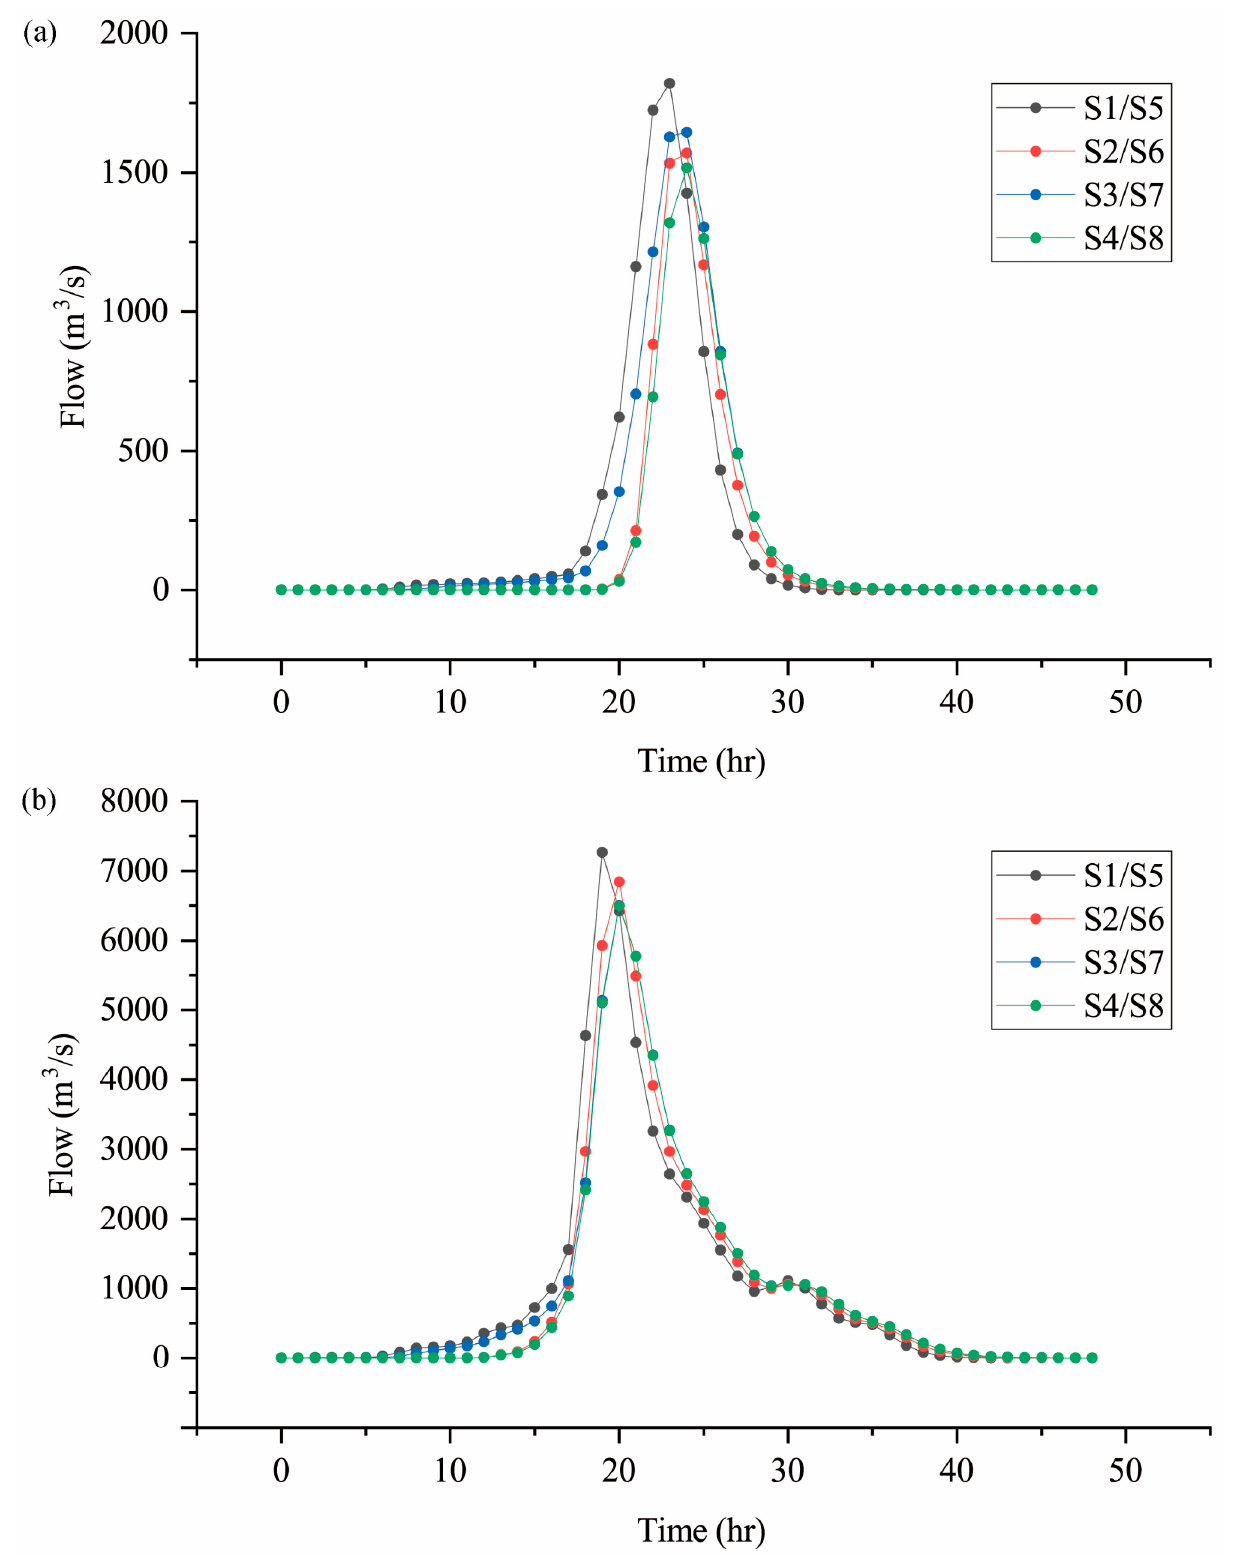
Figure 13. The hydrographs of different scenarios in RT I (a) and RT II (b).